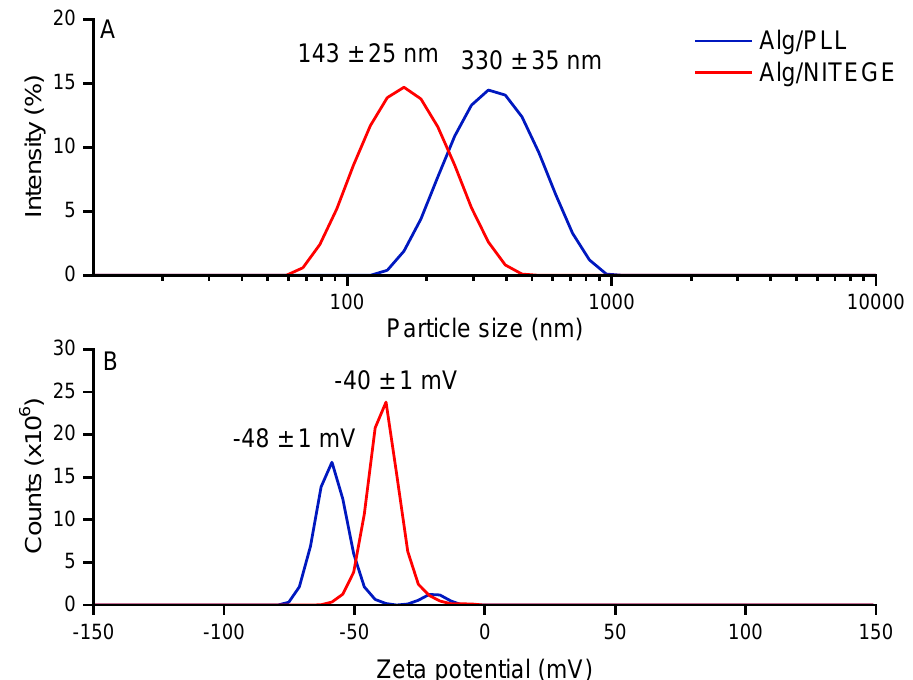
Figure 1. ( A ) Particle size distributions and ( B ) zeta potential curves of alginate/ α -poly-L-lysine (Alg/PLL) and alginate/KKKK-GRD-ARGSV ↓ NITEGE-DRG-KKKK (Alg/NITEGE) nanoparticles in MilliQ, obtained through dynamic light scattering (DLS).